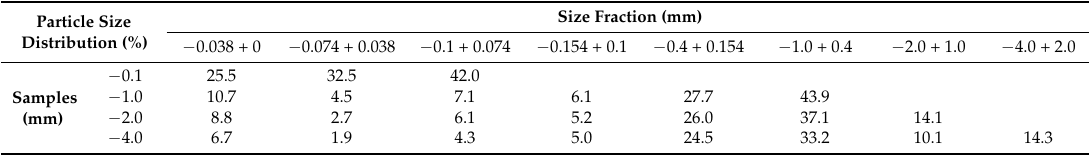
Table 2. Particle size distributions of the crushed